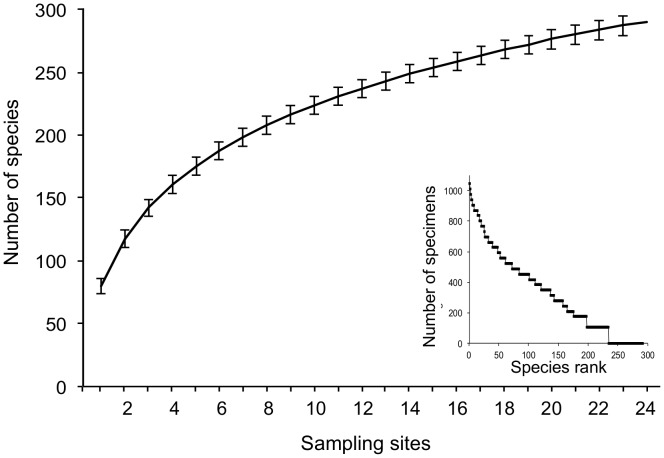
Mean species accumulation curve for pooled data from 2011 and 2012 (1000 randomizations).